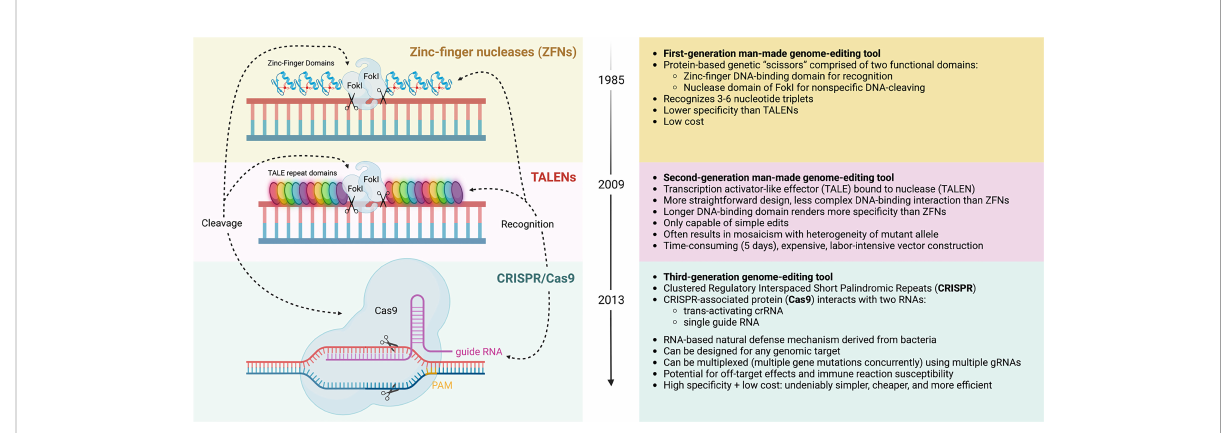
FIGURE 2 Evolution of gene editing toolkits. Zinc- fi nger nucleases (ZFNs) are a fi rst-generation man-made gene-editing tool that consists of two domains: 1) a DNA-cleaving domain comprised of the non-speci fi c nuclease domain of FokI to introduce DNA double-stranded breaks, and 2) two DNA- binding domain chains, called “ fi nger ” modules, each recognizing a unique hexamer (6 bp) sequence of DNA. The fusion of DNA-binding and DNA-cleaving domains forms a pair of “ genomic scissors ” , with high speci fi city but lower than that of Transcription activator-like